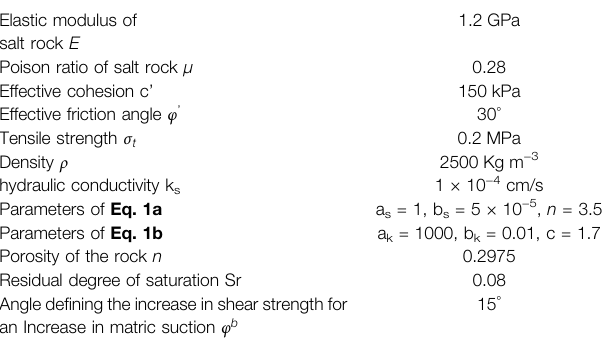
TABLE 1 | Mechanics parameters of the model.